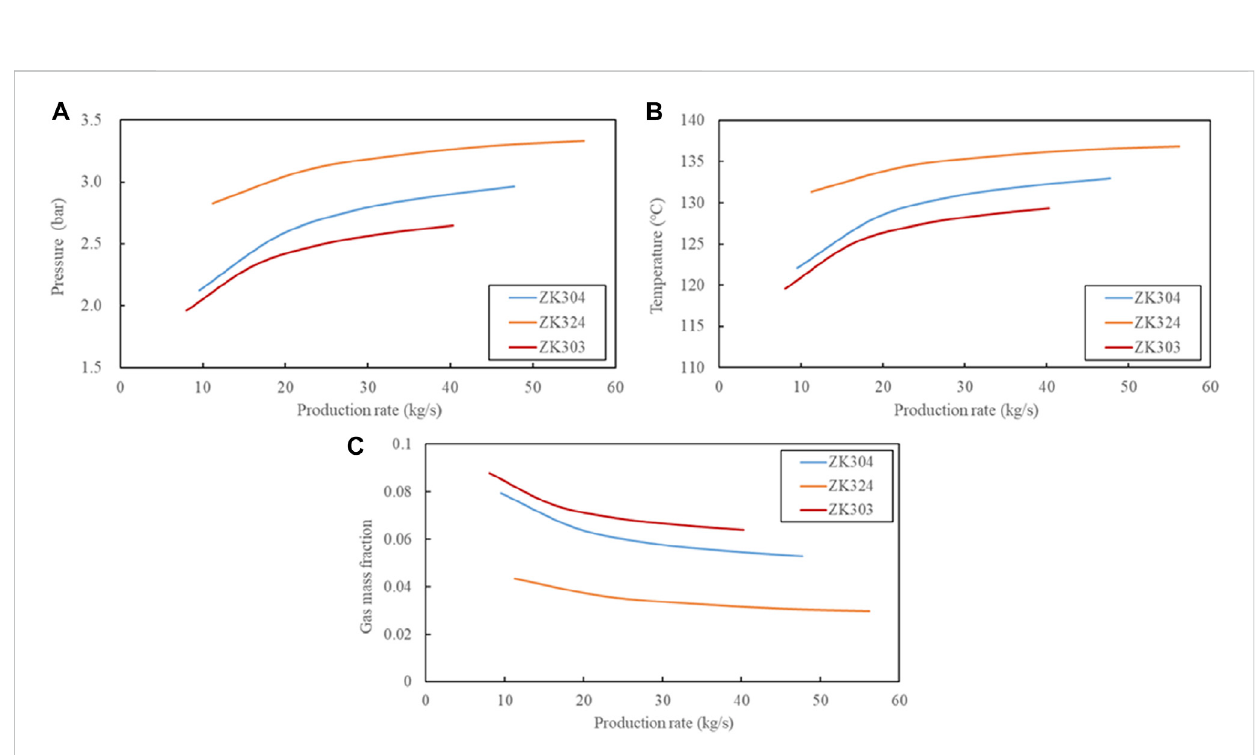
FIGURE 13 Effect of production rate on